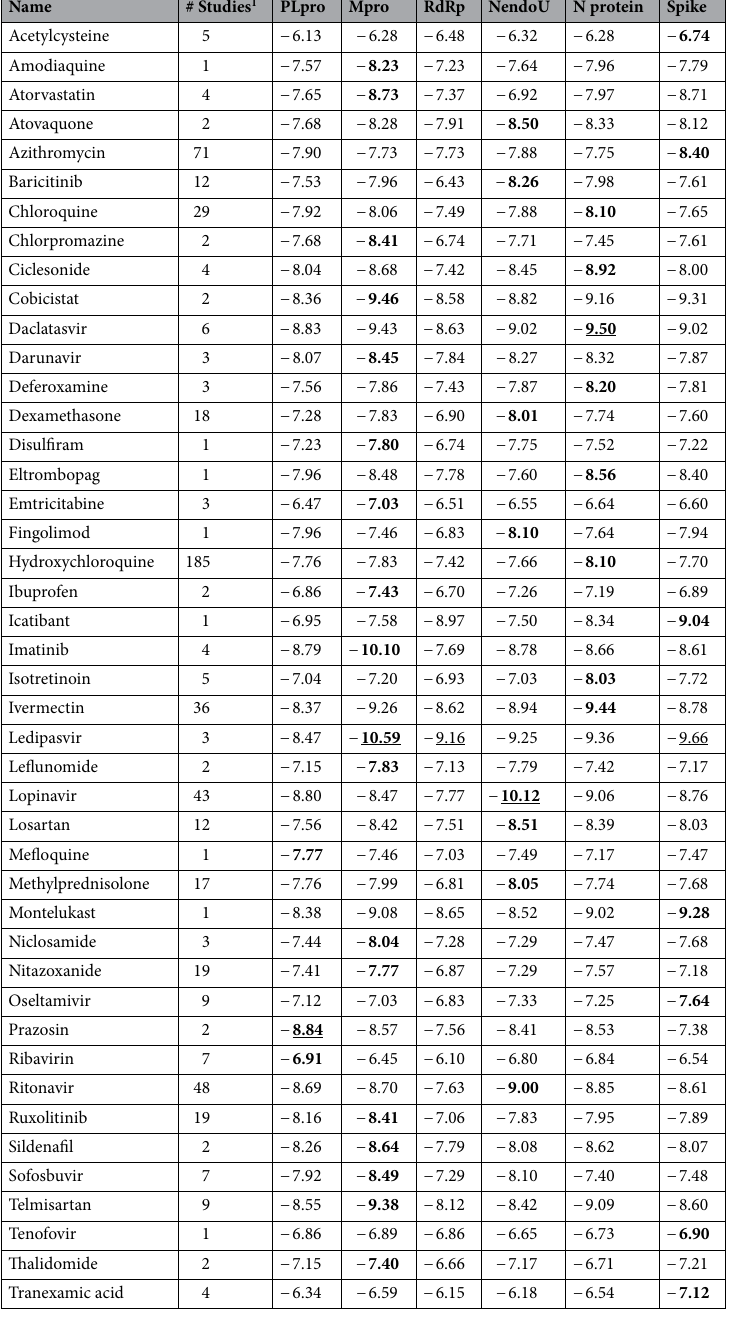
Table 1. Virtual screening results of drugs ongoing clinical trials (accessed on 2020-09-03) for the drug targets available at DockThor-VS. Affinity predictions (kcal/mol) are given for the top-energy pose according to the ensemble docking strategy. The top-scored drug for each target is underlined and the most promising target for each drug is highlighted in bold. The molecular weight (MW) and the number of rotatable bonds (RotB) of each compound are listed in Table S2. 1 Number of clinical trials reported related to COVID-19 by Mapped Drug Intervention at the ClinicalTrials.gov (accessed on 2020-09-03, https ://clini caltr ials.gov/ct2/covid _view/ drugs